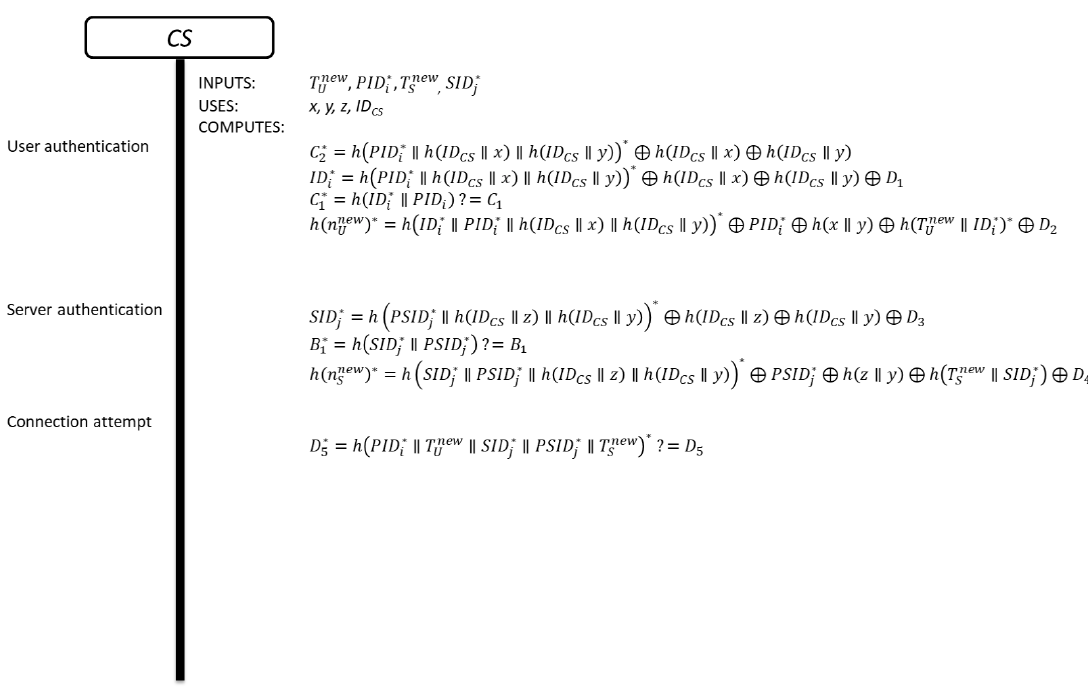
Figure 5. User authentication, server authentication and evidence of connection attempt sub-phases.